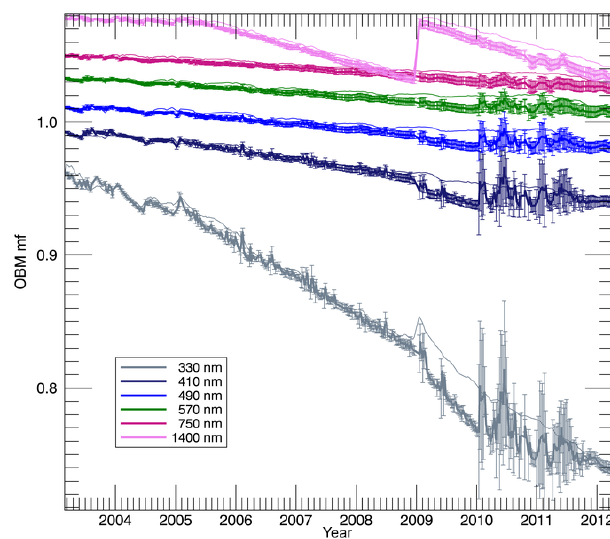
Figure 8. OBM m-factors for some wavelengths as a function of time (mission lifetime in orbit). For each wavelength, two data sets are shown: thin lines indicate values from the ESA V9.01 degrada- tion correction, and thick lines with error bars show the results from the modified degradation model from this study. The time series are vertically shifted for better